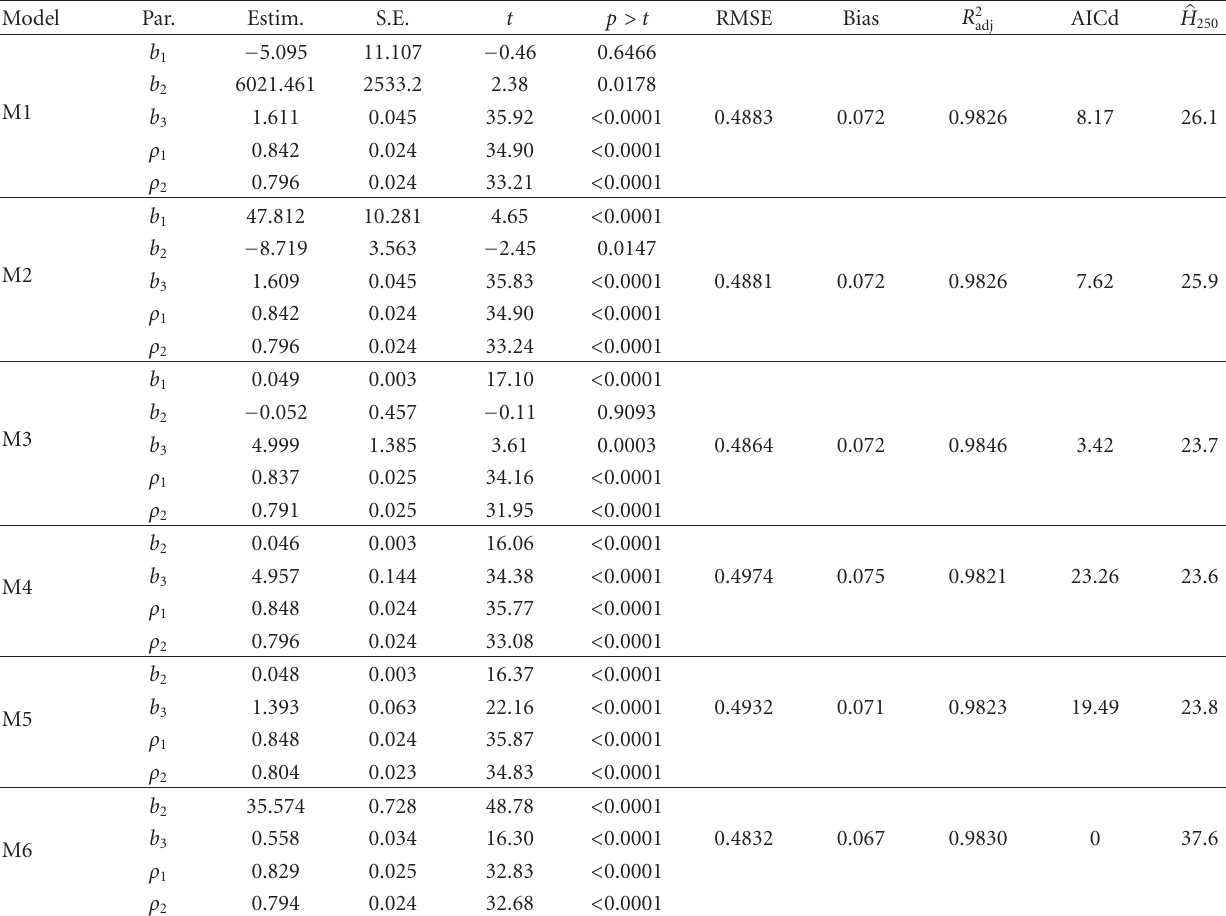
Table 3: Parameter estimates and goodness-of-fit